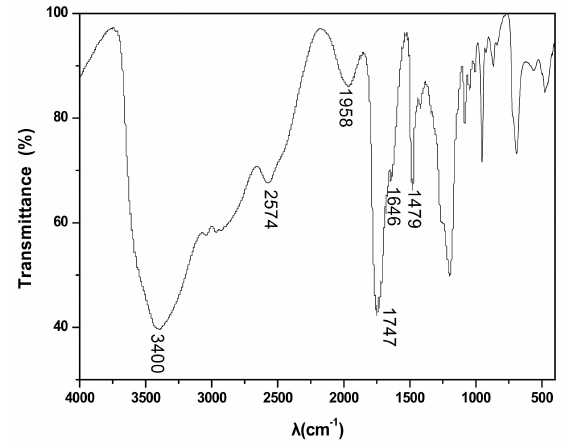
Figure 6. The IR spectrum of choline chloride-oxalic